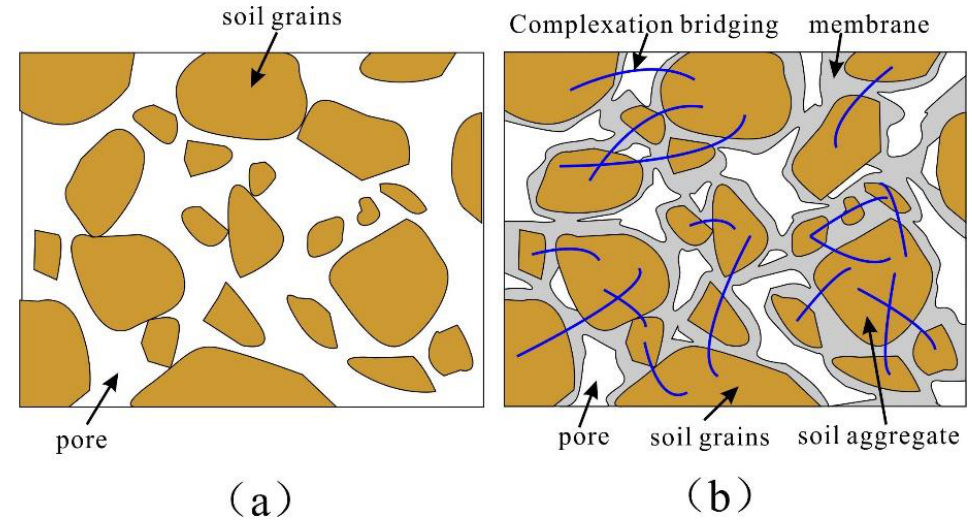
Figure 17. The schematic diagram of effective contact: ( a ) before reinforcement; ( b ) after reinforcement.